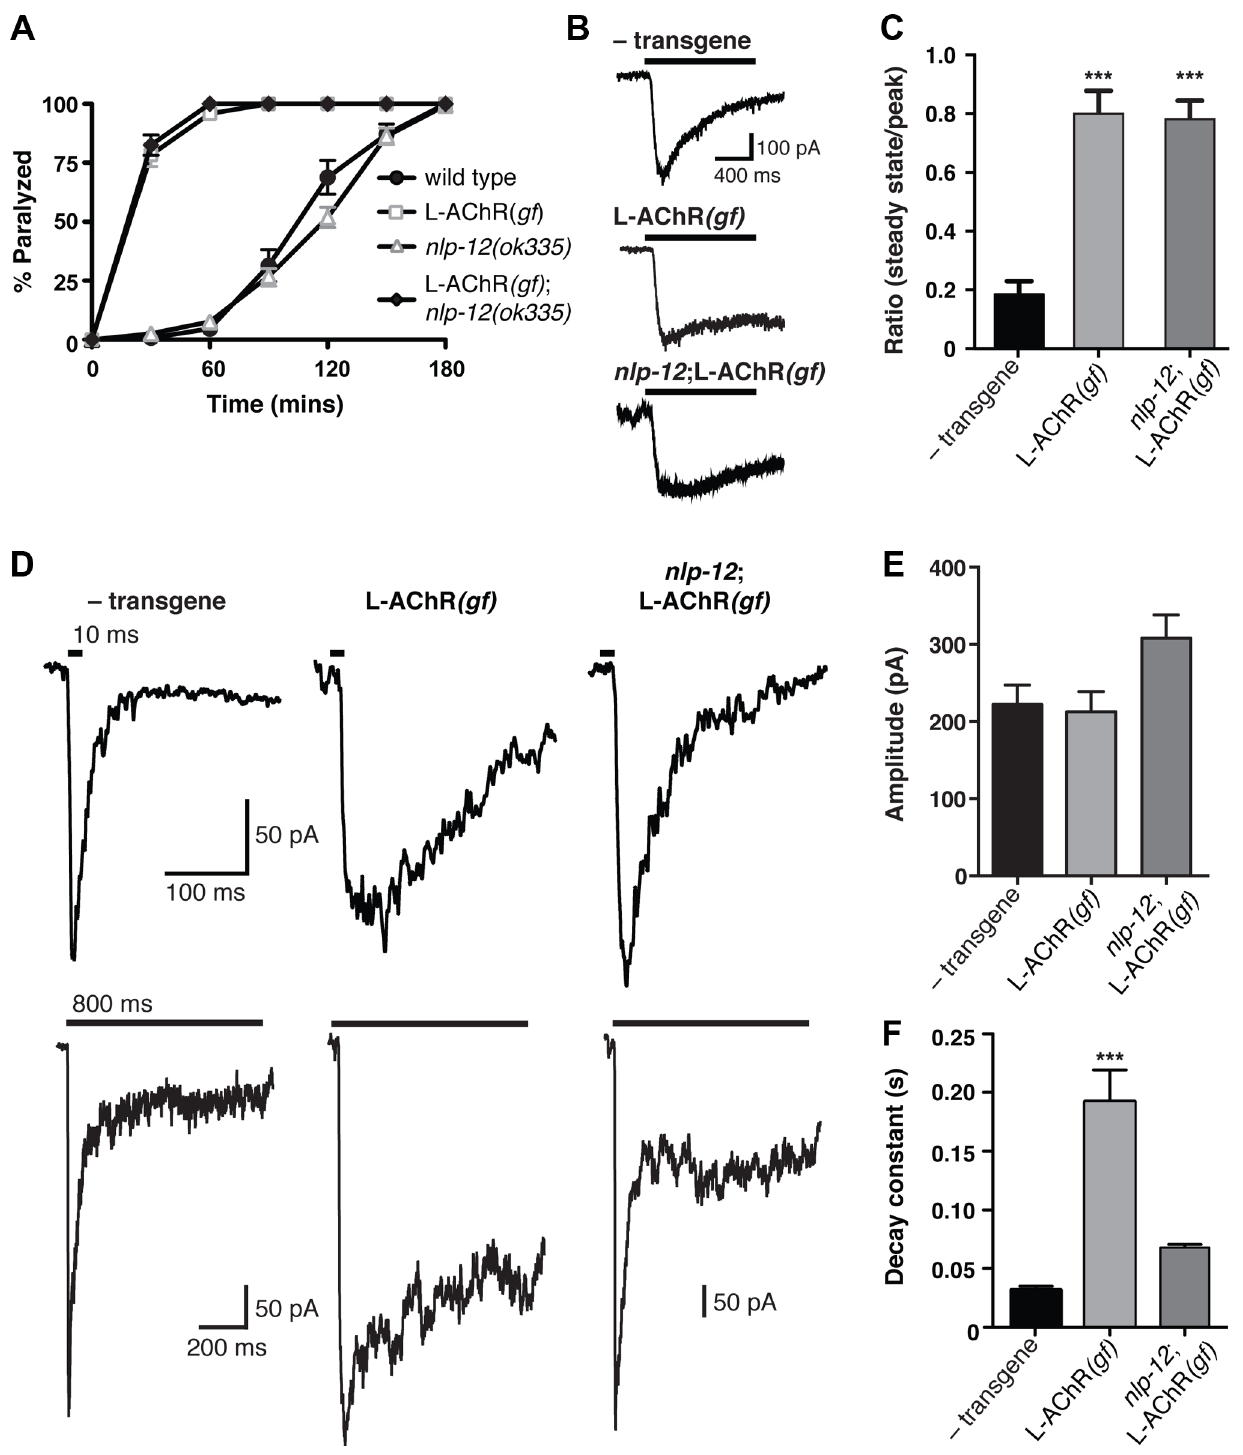
Figure 6. Evoked synaptic responses are prolonged in L-AChR( gf ) animals and require nlp-12 . ( A ) Time course of paralysis in the presence of the L-AChR agonist levamisole (200 m M) for wild type, L-AChR (gf) , nlp-12 mutants and nlp-12 ;L-AChR (gf) animals as indicated. Each data point represents the mean ( 6 SEM) for at least 10 trials. ( B ) Current responses to pressure application (1 s) of levamisole (500 m M) recorded from body wall muscles of control ( 2 transgene) (n=5), L-AChR (gf) (n=6) and nlp-12 ;L-AChR( gf ) (n=4) animals as indicated. Holding potential was 2 60 mV. ( C ) The ratio of the current amplitude 1 s after the start of levamisole application (steady state) to the peak current for control, L-AChR( gf ), and nlp-12 ;L- AChR( gf ) animals as indicated. ( D ) Current responses to photostimulation of motor neurons (10 ms, upper or 800 ms, lower) recorded from body wall muscles of control, L-AChR( gf ), and nlp-12 ;L-AChR( gf ) animals as indicated. Holding potential was 2 80 mV. Recordings were made in the presence of the N-AChR antagonist dH b E (10 m M) to isolate the L-AChR mediated current. ( E, F ) Average amplitude (E) decay time constant (F) for synaptic responses to 10 ms motor neuron photostimulation for the genotypes indicated. The decay phase of L-AChR mediated evoked current responses